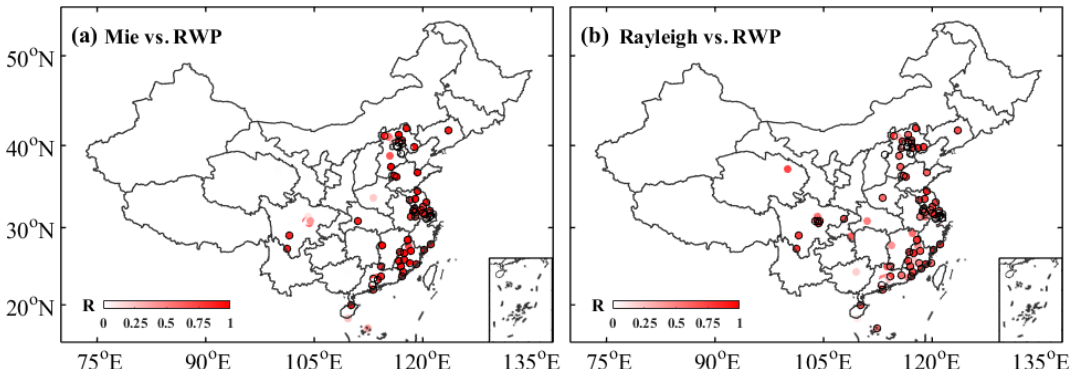
Figure 6. Correlation coefficients between Aeolus HLOS and RWP HLOS wind speeds. The wind measurements are separated in (a) Mie- cloudy winds and (b) Rayleigh-clear winds. The black circles indicate that the site passed the significance test ( P< 0 .